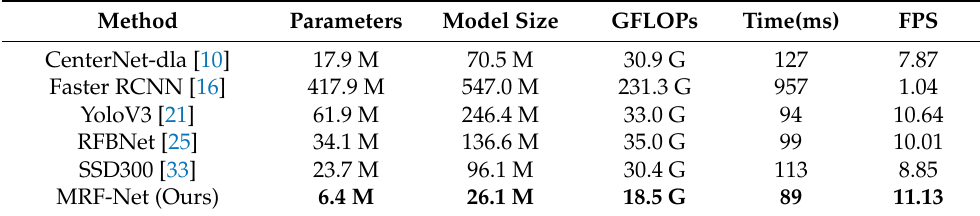
Table 4. Comparison of networks in terms of number of parameters, model size, the amount of calculation (GFLOPs), and frames per second (FPS) (the best result is